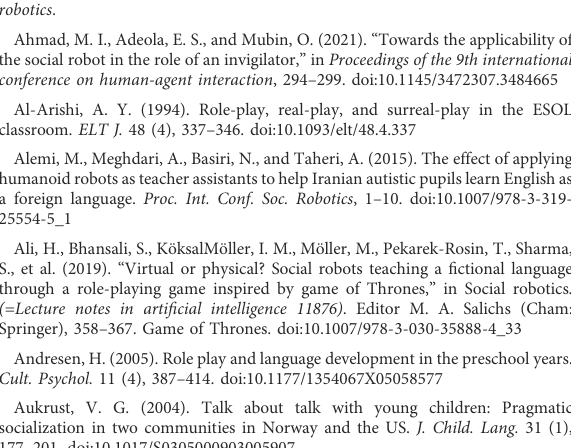
Figure 1. All authors contributed to the fi nal